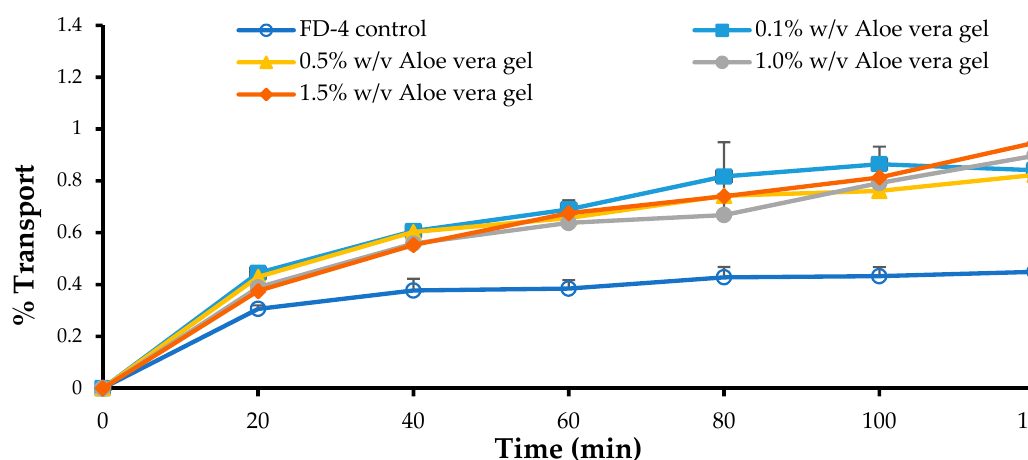
Figure 4. Percentage transport of the Fluorescein isothiocyanate (FITC)-dextran (FD) (FD-4 with MW of 4 kDa) plotted as a function of time, across the Caco-2 cell monolayers, in the absence (FD-4 control) and presence of the Aloe vera gel solutions, with different concentrations ( n = 3; error bars represent SD)